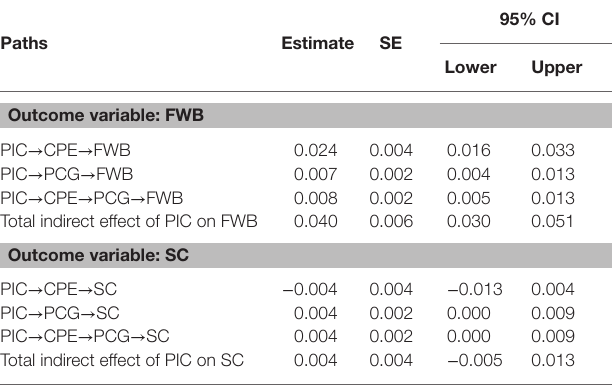
TABLE 5 | Indirect effects of PCI on FWB and SC for the pooled sample.